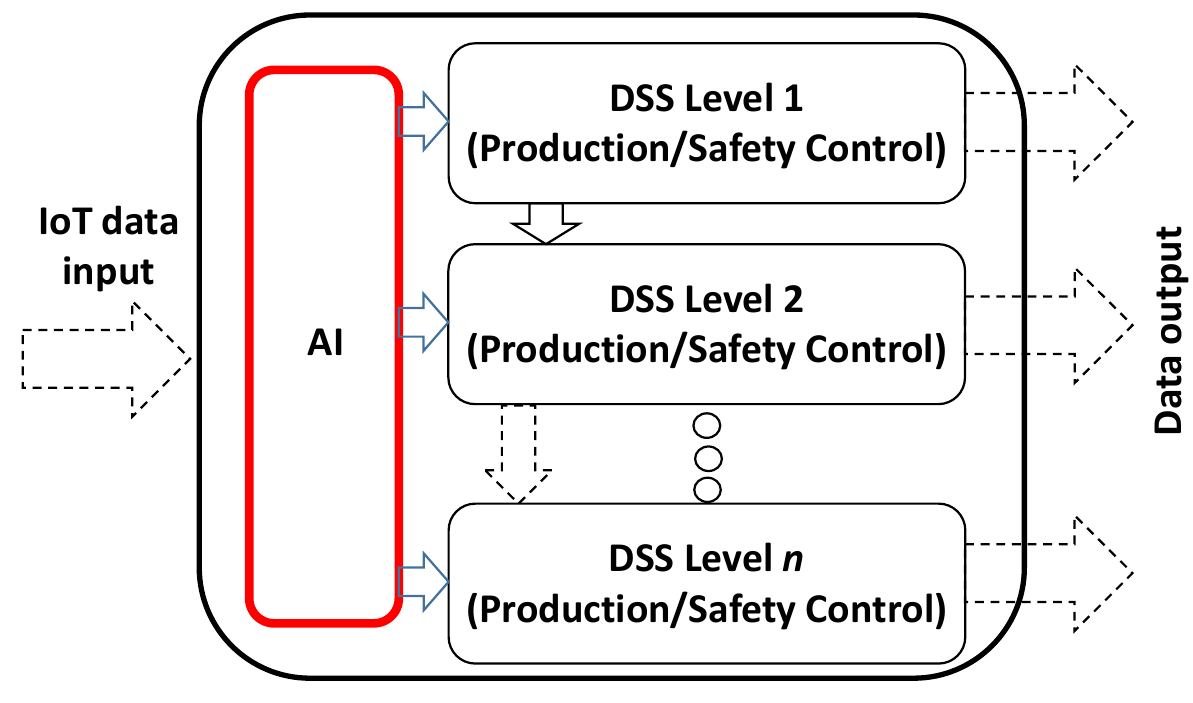
Figure 1. Block diagram of the “ proof of concept ” of the main PM model controlling production and worker safety by means of a multi-level DSS interconnected to AI algorithms.